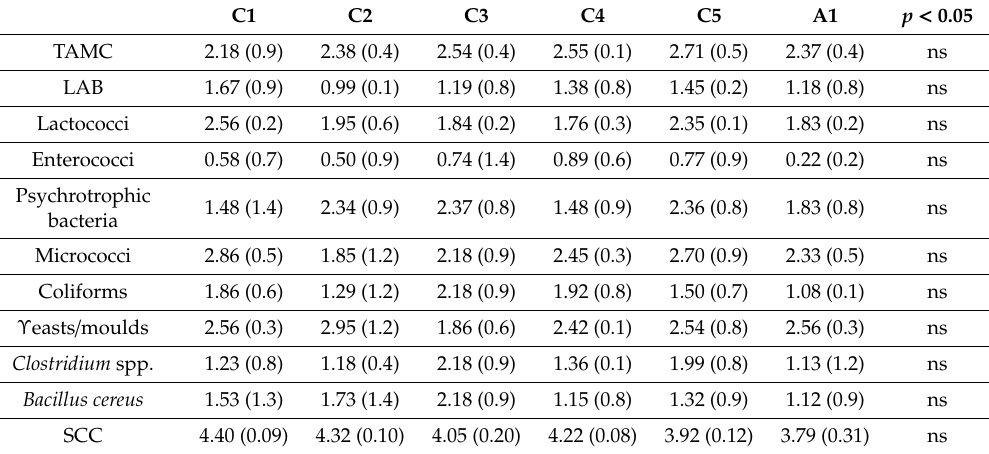
Table 3. Microbiological profile (in log CFU Ml − 1 ) and somatic cell counts (in log cells mL − 1 of the donkey milk